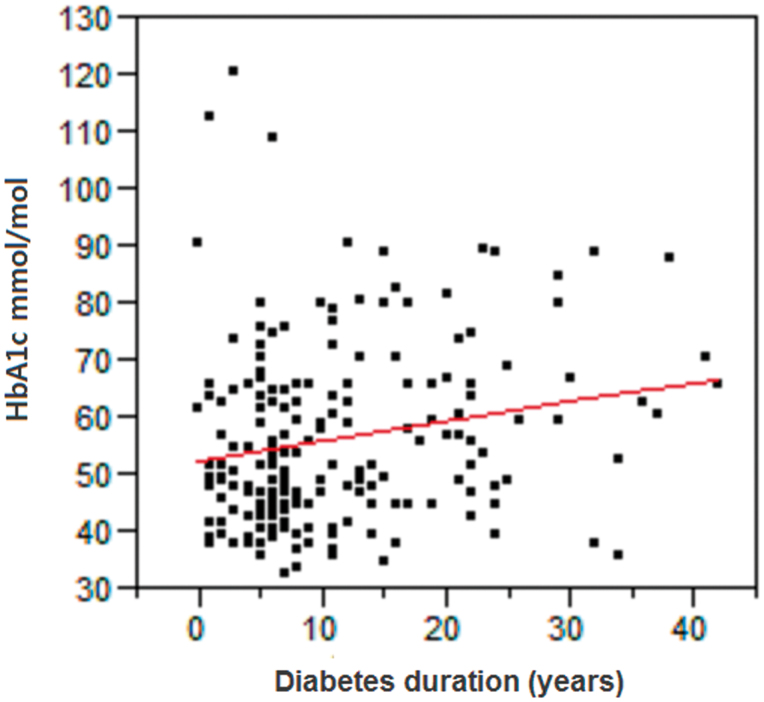
The correlation between HbA1c (mmol/mol) and diabetes duration (years); P = 0.006.